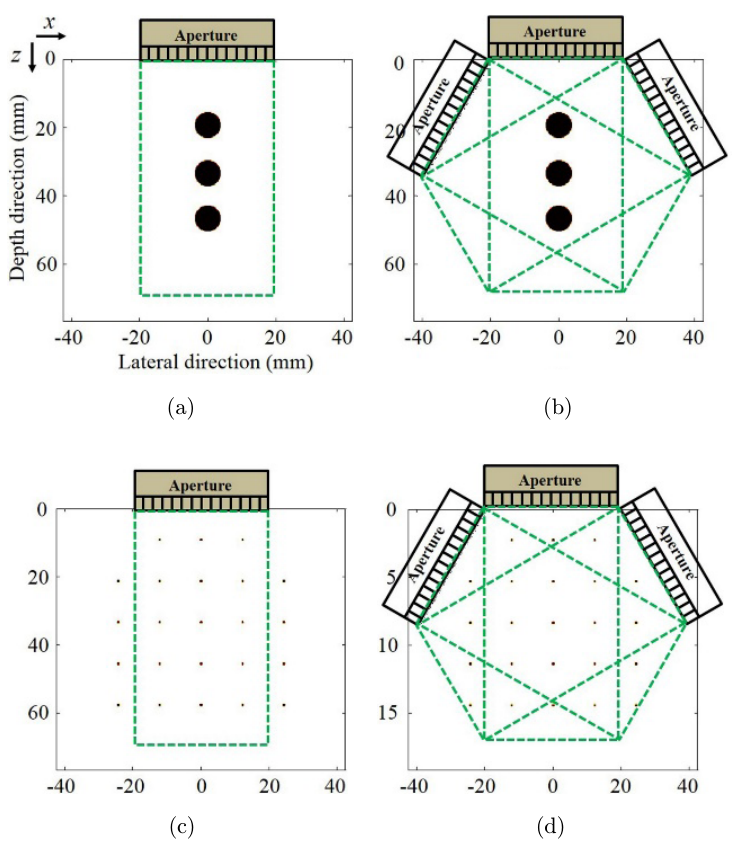
Fig. 2. Numerical model of aperture orientation e®ect in synthetic aperture PAT. Limited-view problem demonstrated respectively in (a) single aperture and (b) synthetic aperture. Enhanced resolution model shown in (c) single aperture and (d) synthetic aperture,